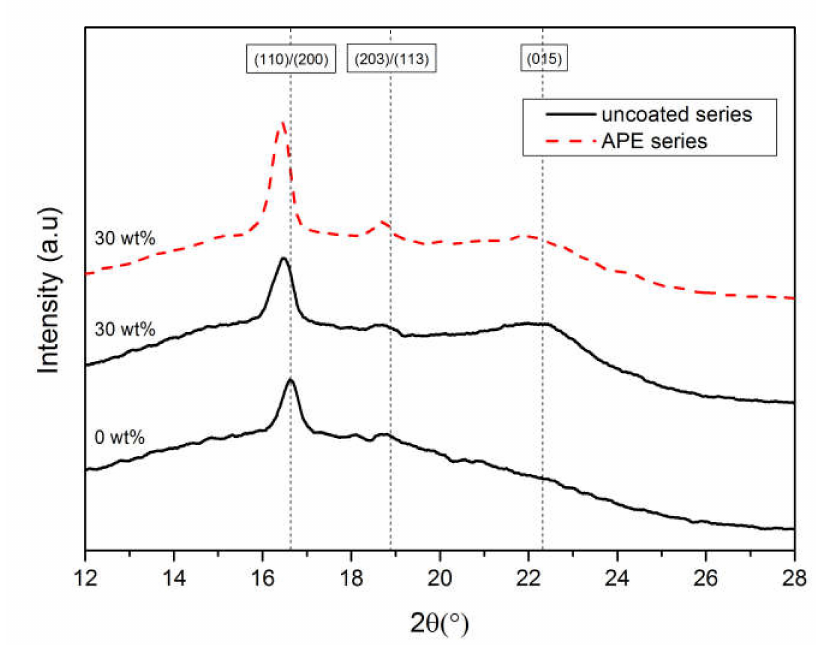
Figure 3. Instrumental-background corrected wide-angle X-ray di ff raction (WAXD) patterns of compression molded sheets of PLLA and composites filled with 30 wt %. Symbols: PLLA / wood ( (cid:121) ); PLLA / wood / APE ( ---